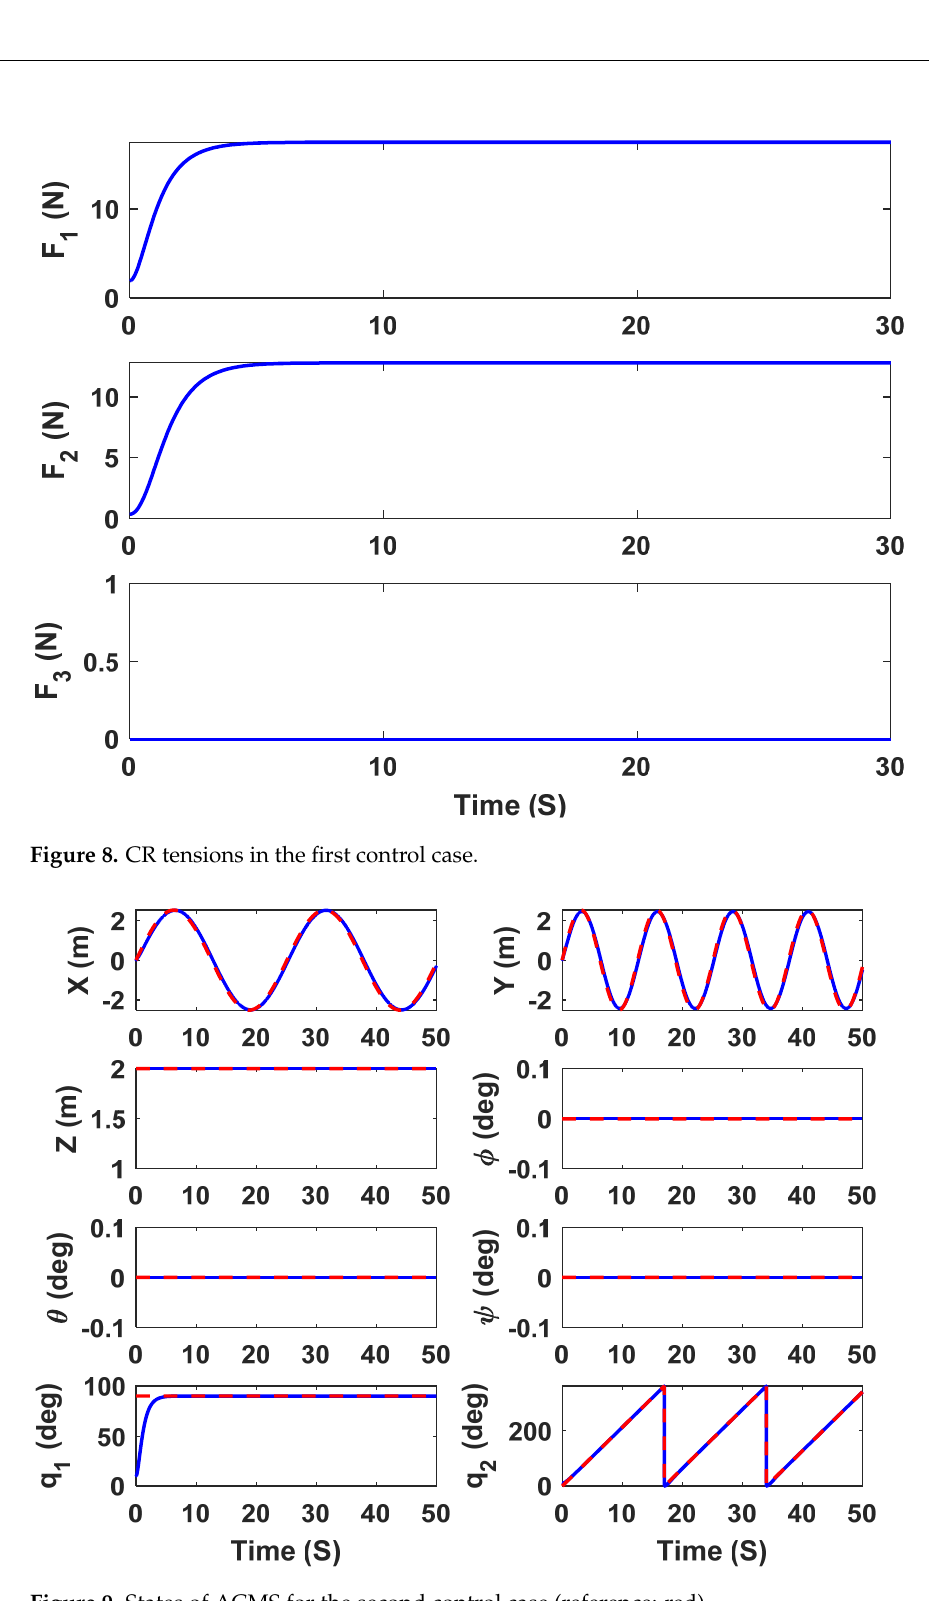
Figure 9. States of ACMS for the second control case (reference: red).